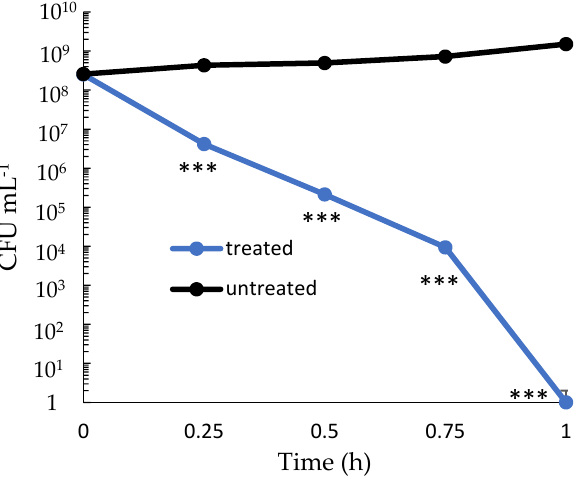
Figure 4. Time-kill kinetics of Spg-A at 4× MIC against V. parahaemolyticus . Experimental procedure and data analysis and presentation are as described in Figure 2. (*** = p < 0.001) These data indicate dose-dependent killing of MRSA by marine sponge bis-indoles.